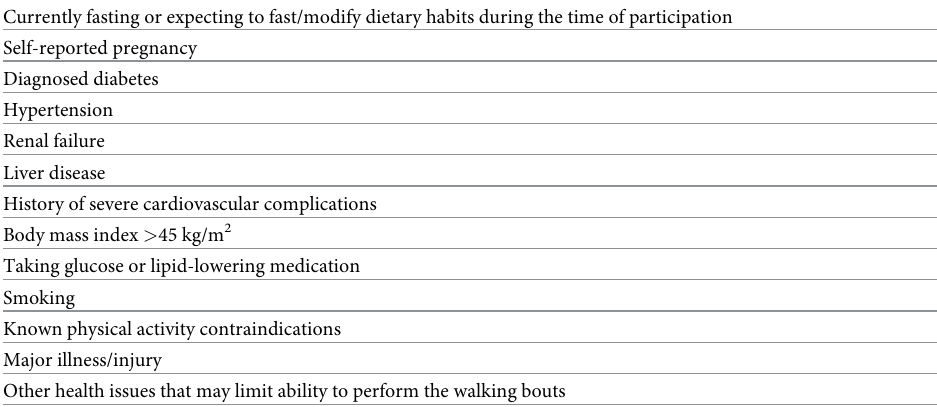
Table 1. Participant exclusion